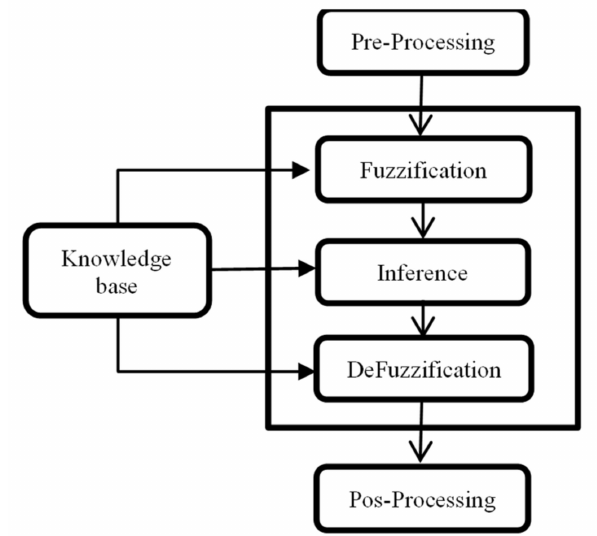
Figure 1. Fuzzy Logic Modeling.